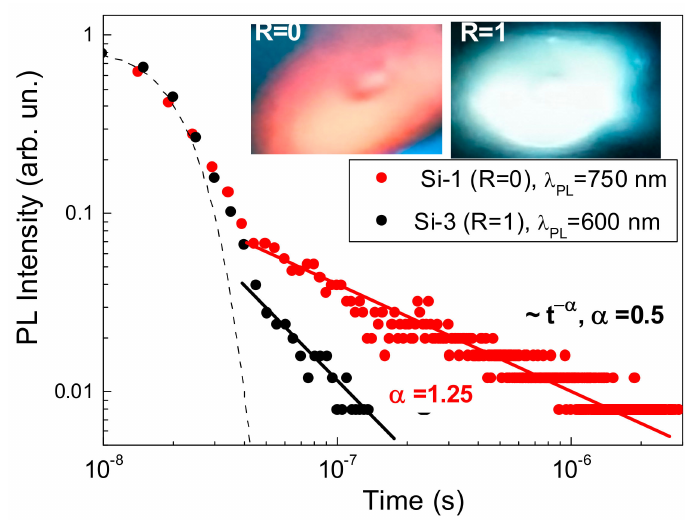
Figure 6. PL transients from samples Si-1 and Si-3 obtained for two di ff erent ratios between helium and nitrogen pressures (R = 0 and R = 1, respectively). Dashed line indicates time response of the detection system, while solid black and red lines are power law approximations with exponents of 0.5 and 1.25, respectively. Left and right insets show digital images of the PL spots (2 × 3 mm 2 ) on the top of samples Si-1 and Si-3, respectively. PL was excited by 20 ns laser pulses at 351